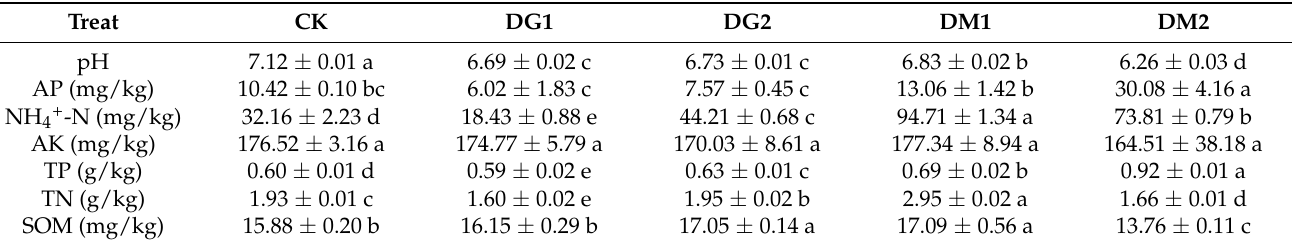
Table 1. Soil physicochemical data under different treatments. “a, b, c, d, e” indicates the significance of differences between